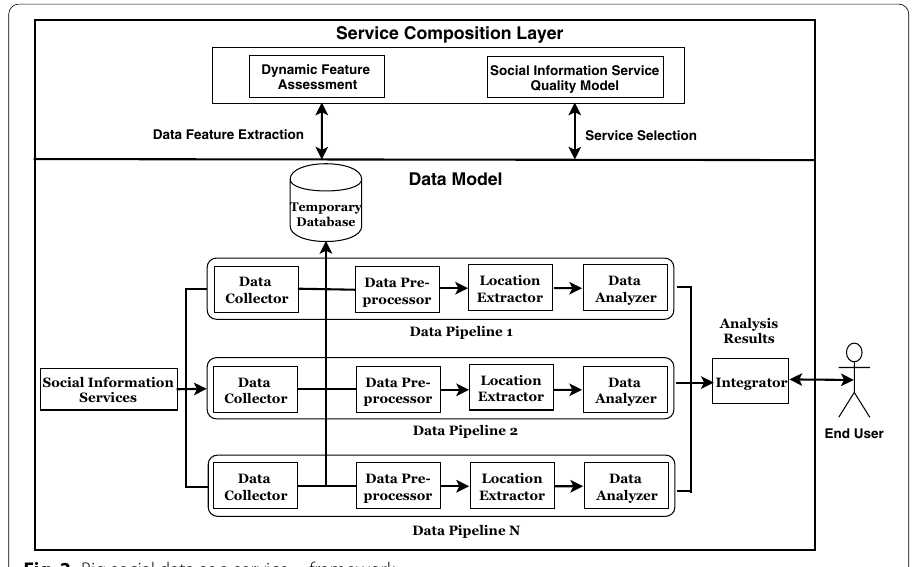
Fig. 2 Big social data as a